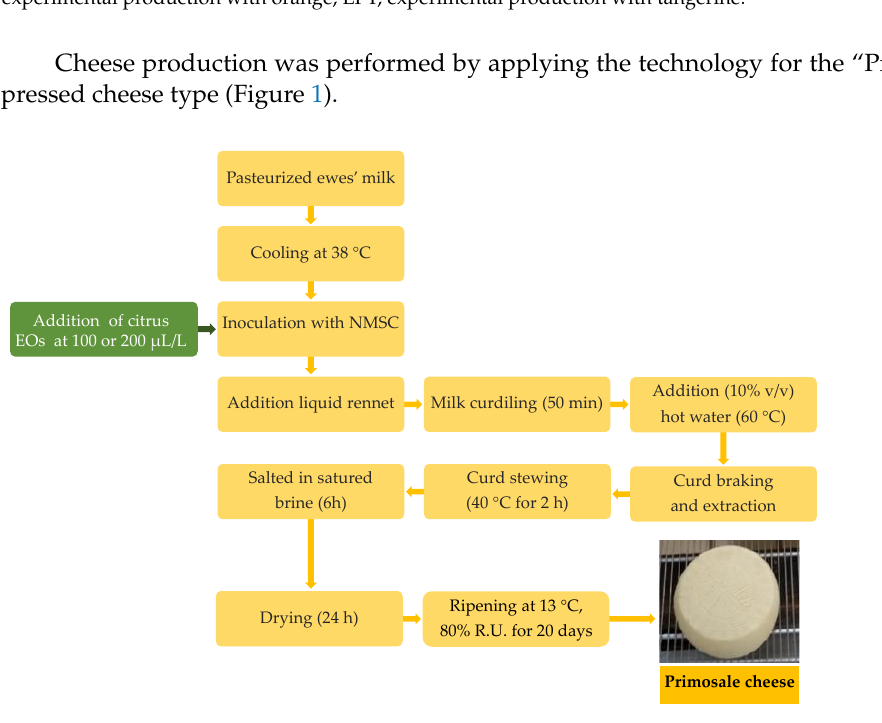
Figure 1. Flow diagrams of Primosale cheese production enriched with citrus essential oils. Abbrevi- ations: EOs, essential oils; NMSC, natural milk starter